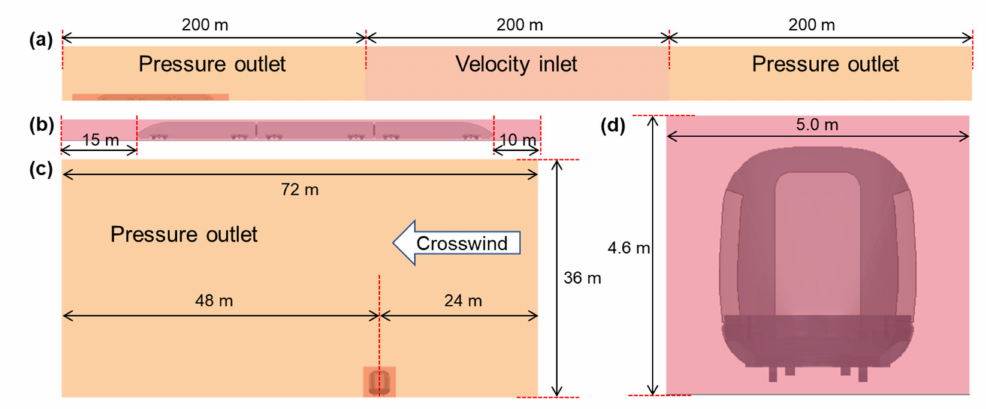
Figure 2. Computational domain and boundary conditions: ( a ) overall side view; ( b ) side view of the overset region; ( c ) front view of the computational domain; ( d ) front view of the overset